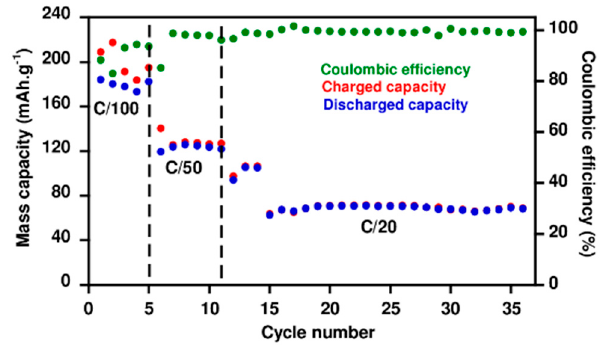
◦ 4 cell at indicating rates at 100